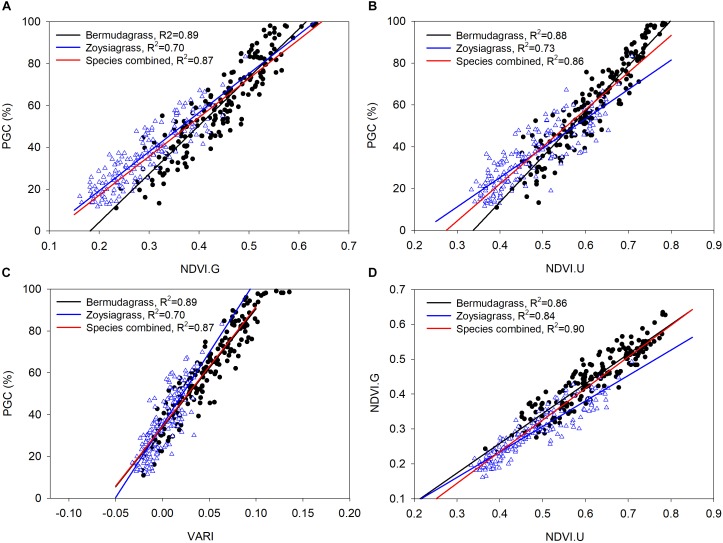
Linear regressions in predicting percent green cover (PGC) using (A) Ground NDVI, (B) UAV-based NDVI, and (C) VARI. (D) In predicting ground NDVI using UAV-based NDVI. Triangle points represented zoysiagrass and circled points represented bermudagrass.